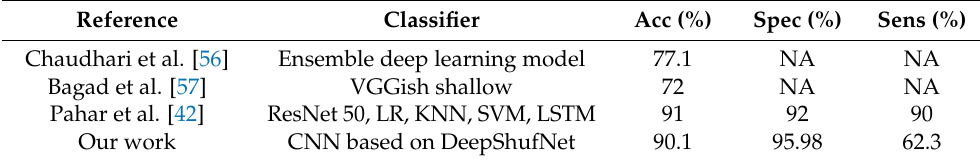
Table 10. Comparison with other